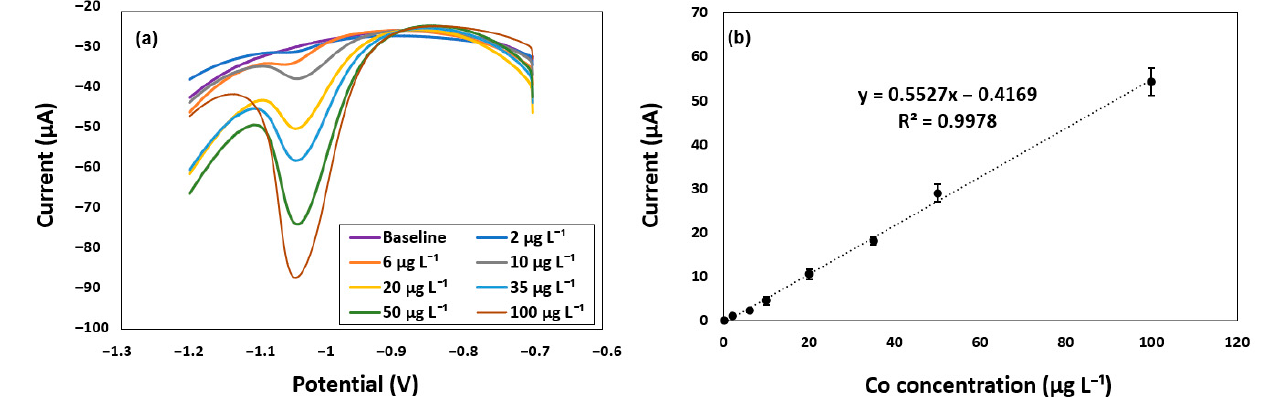
Figure 3. Characterization and evaluation of the Bi ‐ chitosan sensor for Ni(II) detection. ( a ) SWAdCSV with various Ni(II) concentrations (5–100 μ g L − 1 ) and ( b ) a corresponding calibration curve. Deposition time is 120 s with a deposition potential of − 0.9 V, frequency of 120 Hz, amplitude of 50 mV, and DMG concentration of 0.2 mM.